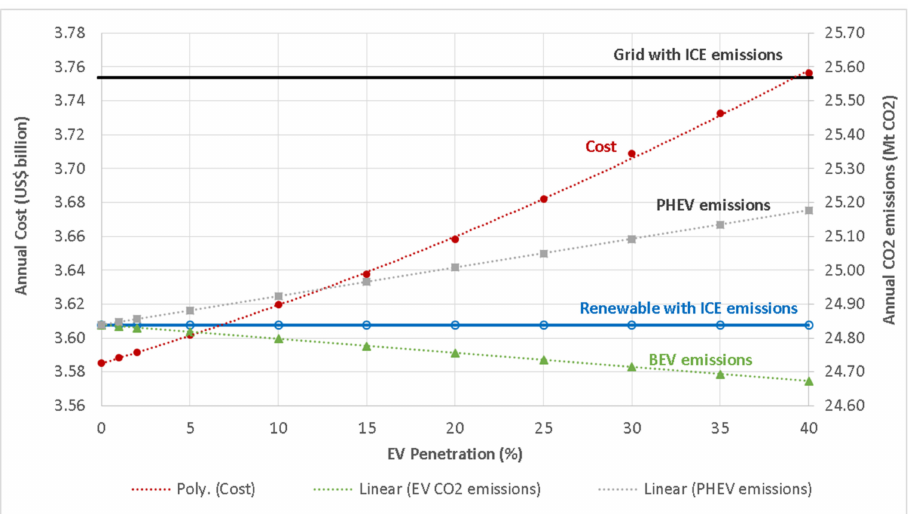
Figure 10. Trade-off between annual cost and carbon emissions for different EV penetration ratios when meeting EV electricity demand.